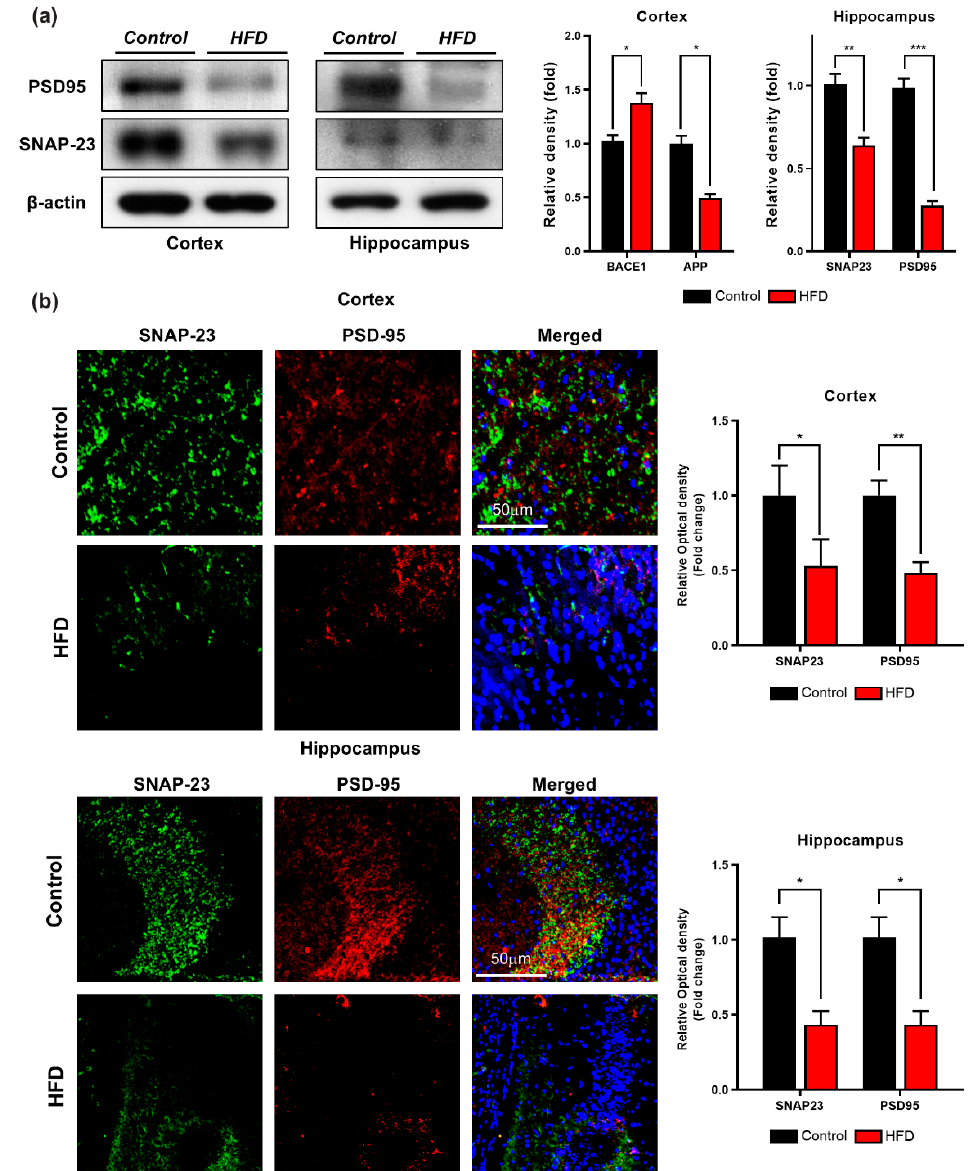
Figure 6. Effect of HFD on synaptic proteins in 24 weeks old HFD mice brain. ( a ) Western blot analysis of synaptosome-associated protein 23 (SNAP-23) and postsynaptic density protein 95 (PSD95) both in cortex and hippocampus along with their respective histograms. β -actin was used as a loading control. ( b ) Immunofluorescence images of pre and post synaptic proteins in the cortex and hippocampus of control and HFD mice brain. Data are presented as mean ± SEM. Data for immunofluorescence and western experiment are compared using the Student’s t -test, and other data are compared using one-way ANOVAs. Data are compared using the unpaired Student t -test. Significance = * p < 0.05, ** p < 0.01, *** p < 0.001.